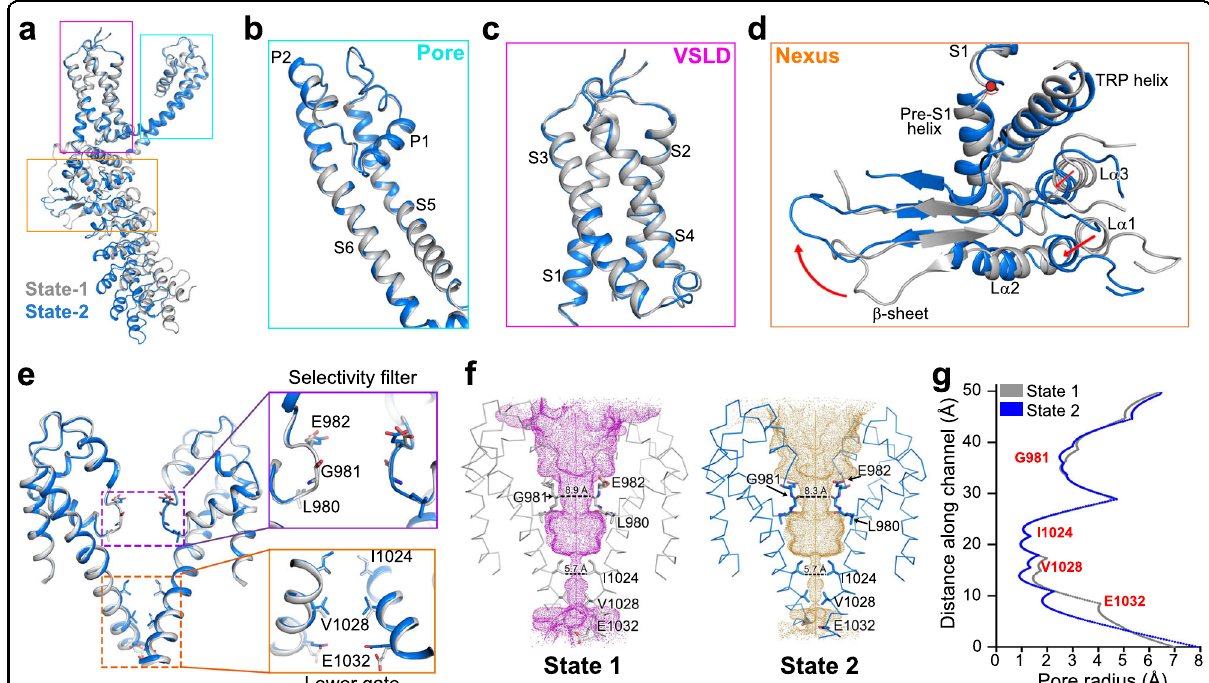
Fig. 2 Both dTRPA1-A structures are in the nonconductive state. a Alignment of the monomeric dTRPA1-A structures of two states. Monomers from state-1 and state-2 are coloured grey and marine blue, respectively. b Structure alignments of the pore region between two states. c Structure alignments of the VSLD region between two states. d The nexus region exhibits a large rotation around the pivotal point (shown as a red circle) at the joint of preS1 and S1 helices. e Comparison of the pore region of dTRPA1-A in two states. Zoomed views of the upper selectivity fi lter and the lower gate are shown from two perpendicular angles. The constriction-site-forming residues are shown as sticks. f Pore depiction of dTRPA1-A in state-1 and state-2. A ribbon diagram is shown for the pore region from diagonally opposed subunits. Side chains of the constricting sites are shown as sticks. The upper gate is formed by residues L980, G981 and E982, and the lower gate is formed by I1024 and V1028. The ion conduction pore, calculated using HOLE2 57 , is shown as magenta or orange mesh for state-1 or state-2, respectively. g Calculated pore radius along the channel. The lower gates have almost identical radii, approximately 1 Å, indicating a nonconductive state for both